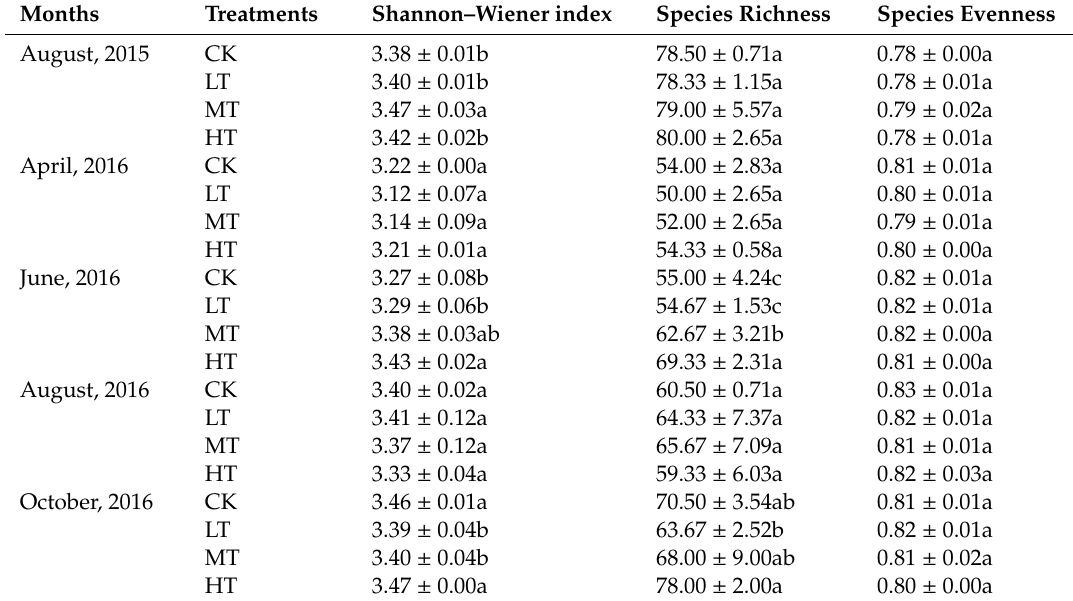
Table 1. Soil microbial community structure diversity in each sampling date after thinning. Months